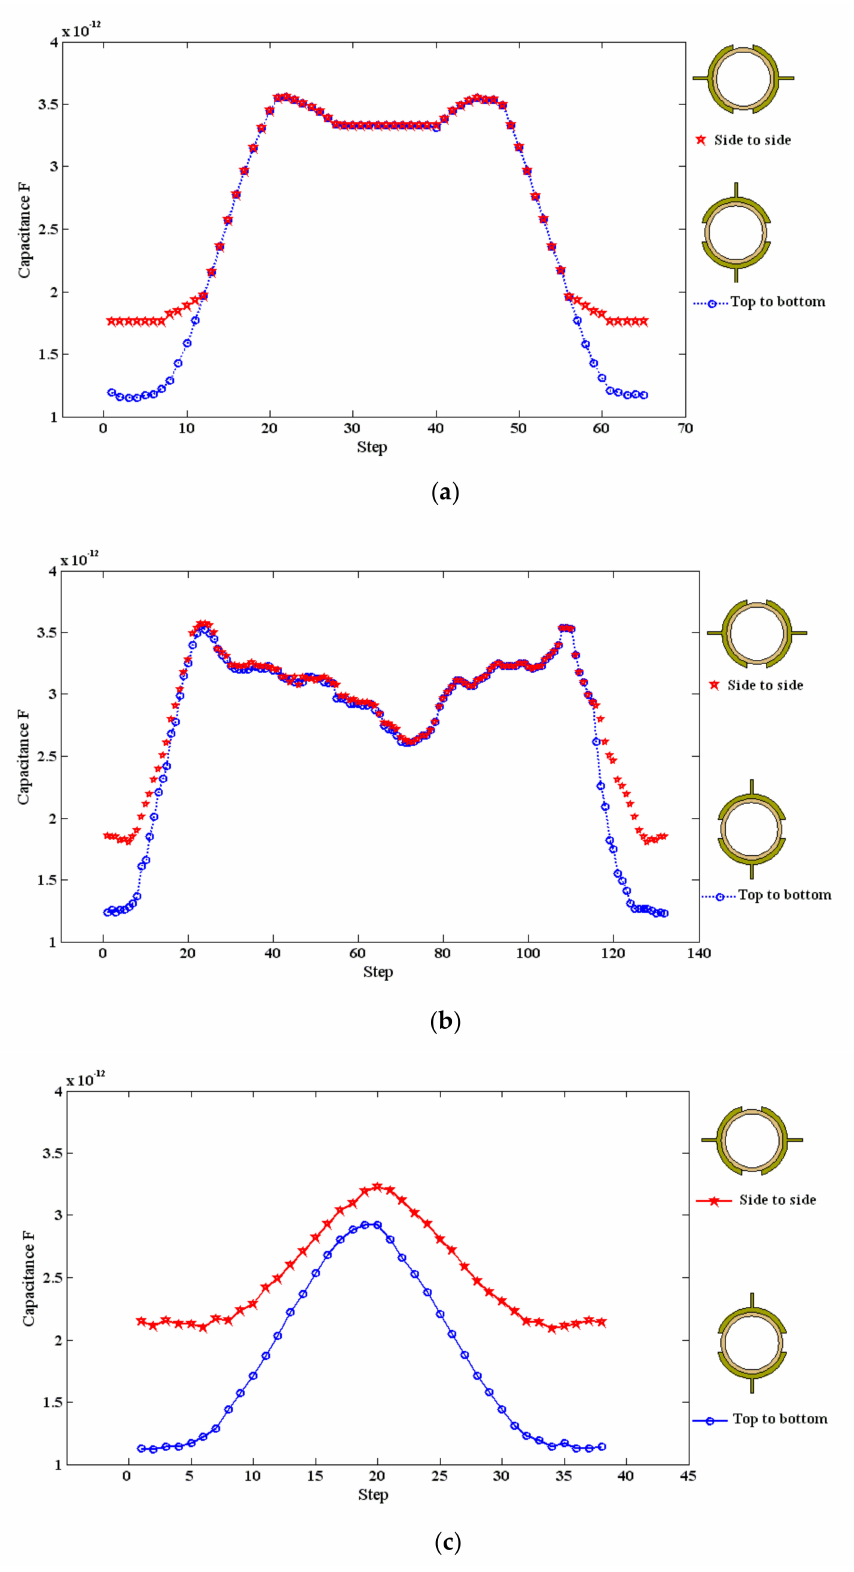
Figure 15. The e ff ect of the sensor orientation on the sensor’s sensitivity and the measured capacitance values for: ( a ) the slug flow; ( b ) the slug–churn flow, and ( c ) the stratified flow (step: the advancement of the flow pattern thorough the pipe by 2